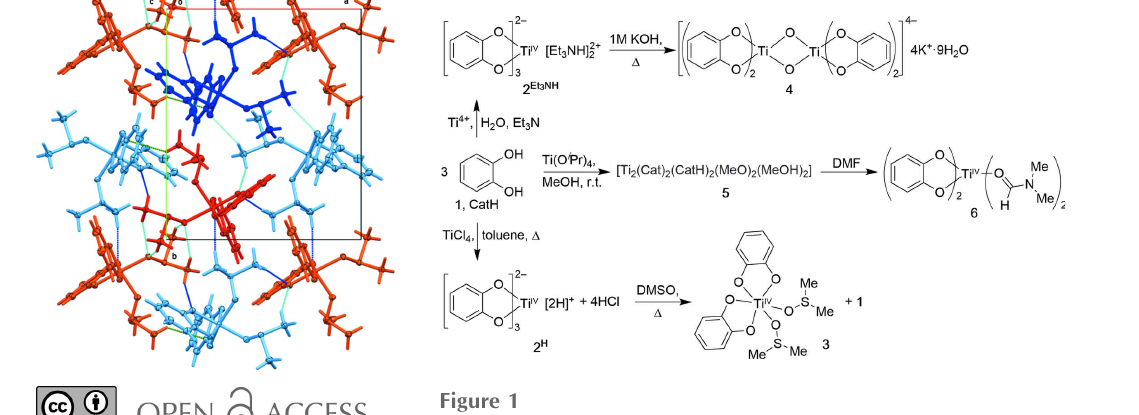
Figure 1 Formation of titanium(IV) catecholate complexes, including the title compound 3